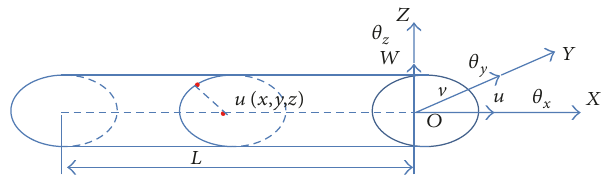
Figure 1: Beam geometry and kinematic